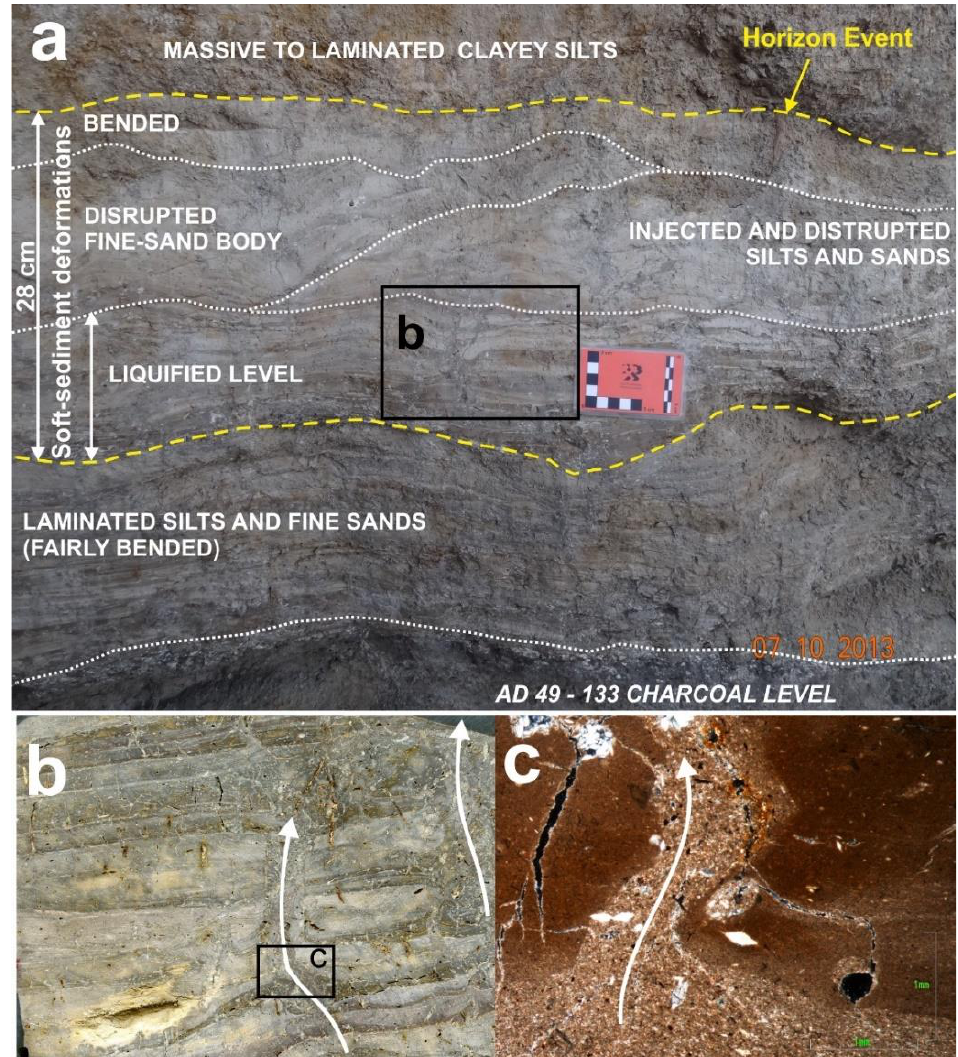
Figure 9. Liquefaction horizon of the Roman period evidencing an ancient earthquake during the Roman period in the studied zone. ( a ) Field outcrop at the base of La Alcanara section displaying convolute lamination ( b ) sediment sample extracted for micromorphological analyses displaying sand dykes, sand flames and ball-and-pillow structures with boudinage morphologies -see location in the quadrangle of Figure 9a-; ( c ) thin section illustrating an injection of fine-sand dike filling hydrofractures in the lower disturbed levels -see location in the quadrangle of Figure. 9b.